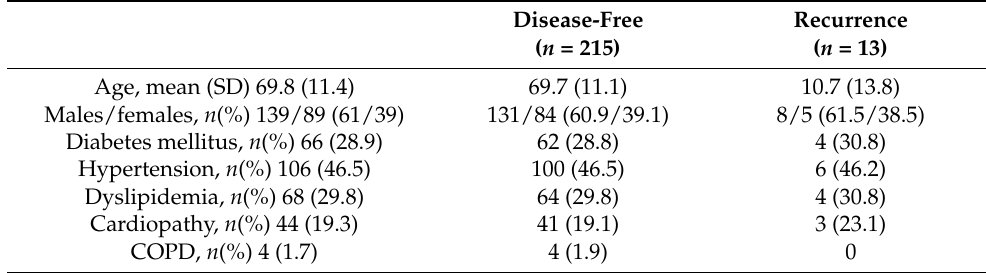
Table 1. Patients’characteristics.